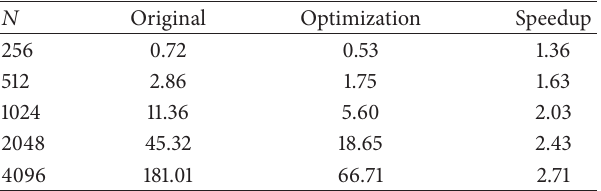
Table 5: Performance improvement for fixed 𝑀 with the optimiza- tion of constant vector multiplication and vector-vector addition.